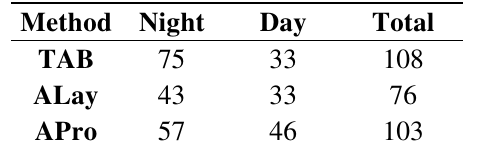
Table 1. Number of PBL heights detected by applying the three methods to CALIPSO aerosol data products.